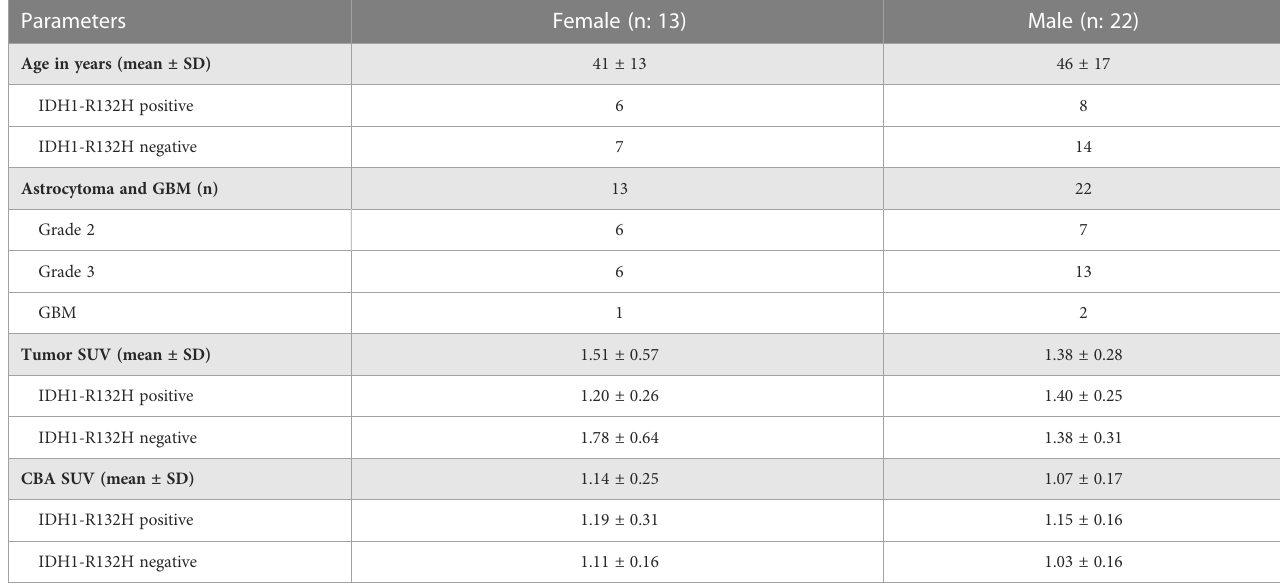
TABLE 1 Demographic and MET-PET imaging characteristics of the study population of 35 astrocytic gliomas based on the WHO classi fi cation 2016 (n=35).